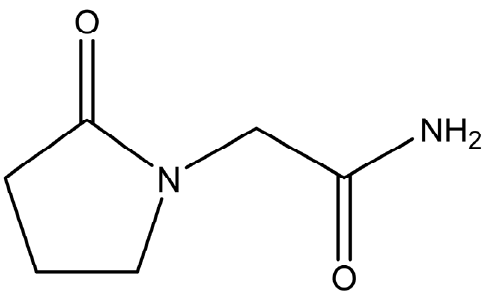
Figure 1. Chemical structure of